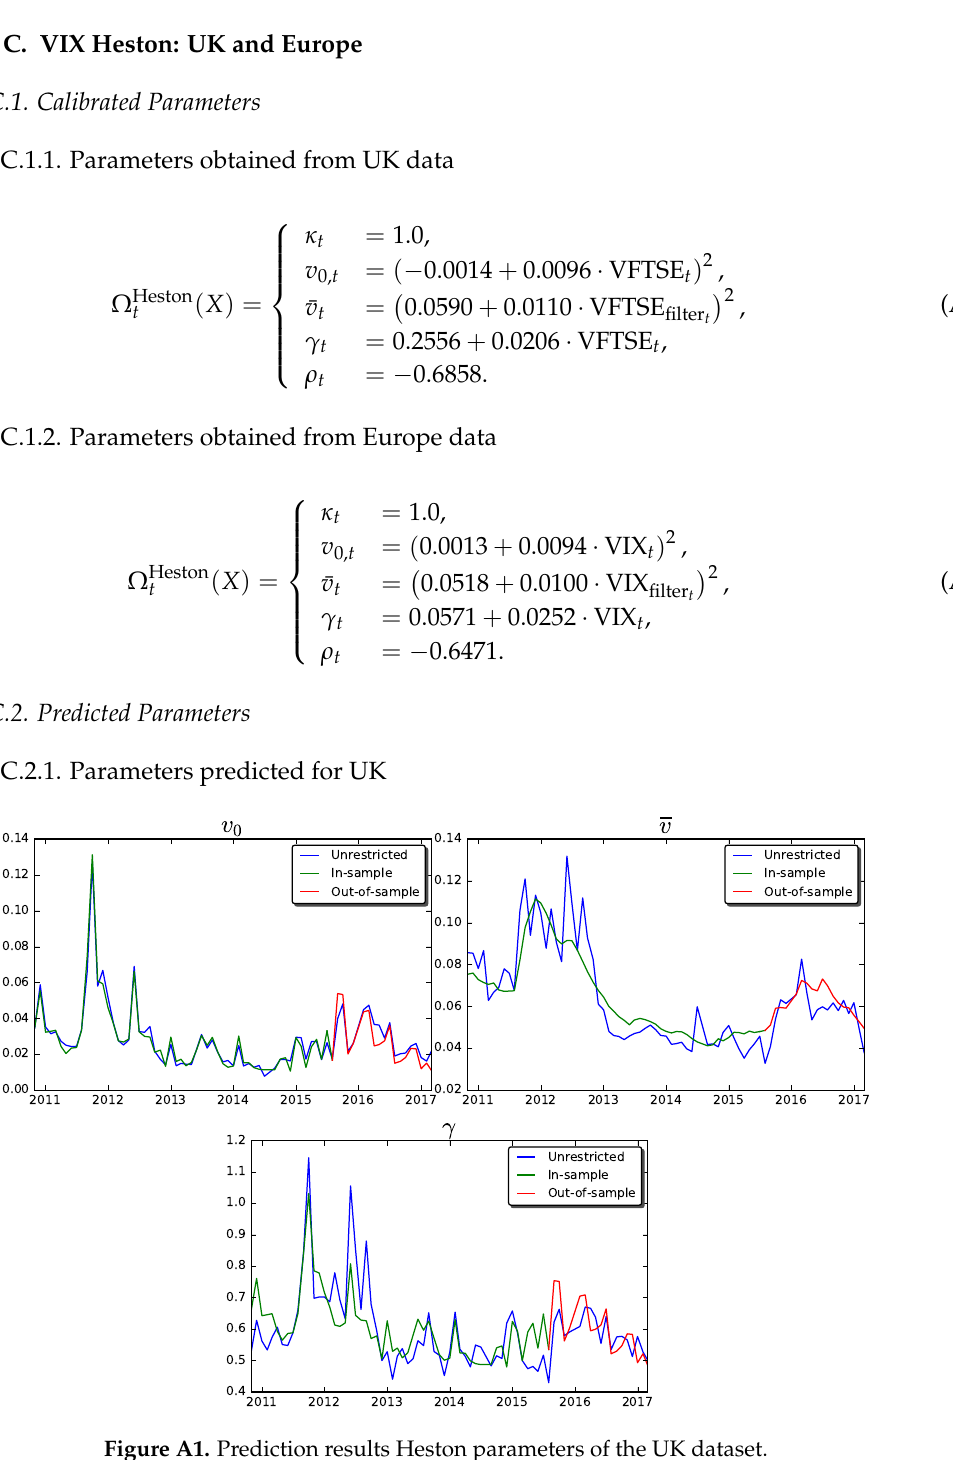
Figure A1. Prediction results Heston parameters of the UK